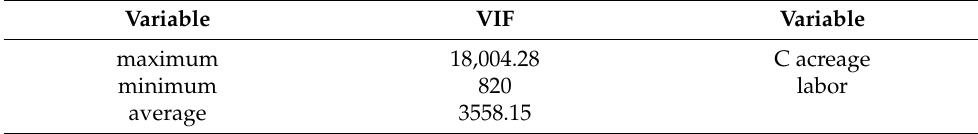
Figure 2. Matrix of correlation coefficients between variables. Table 3. VIF values of each